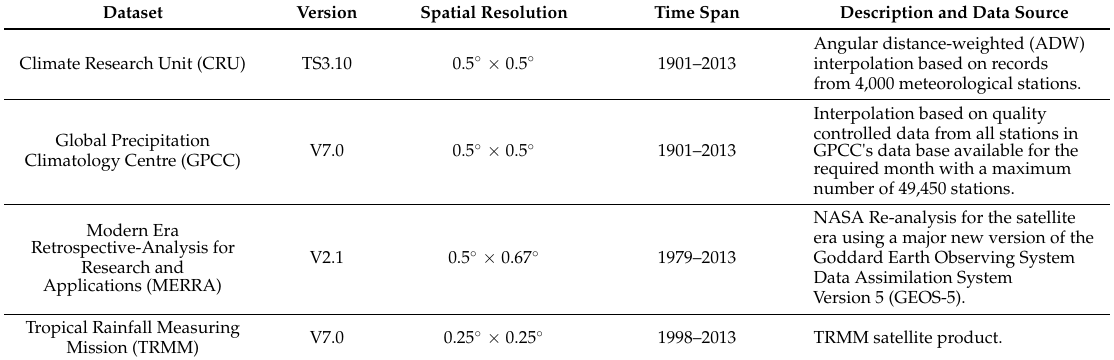
Table 1. Precipitation datasets used in this